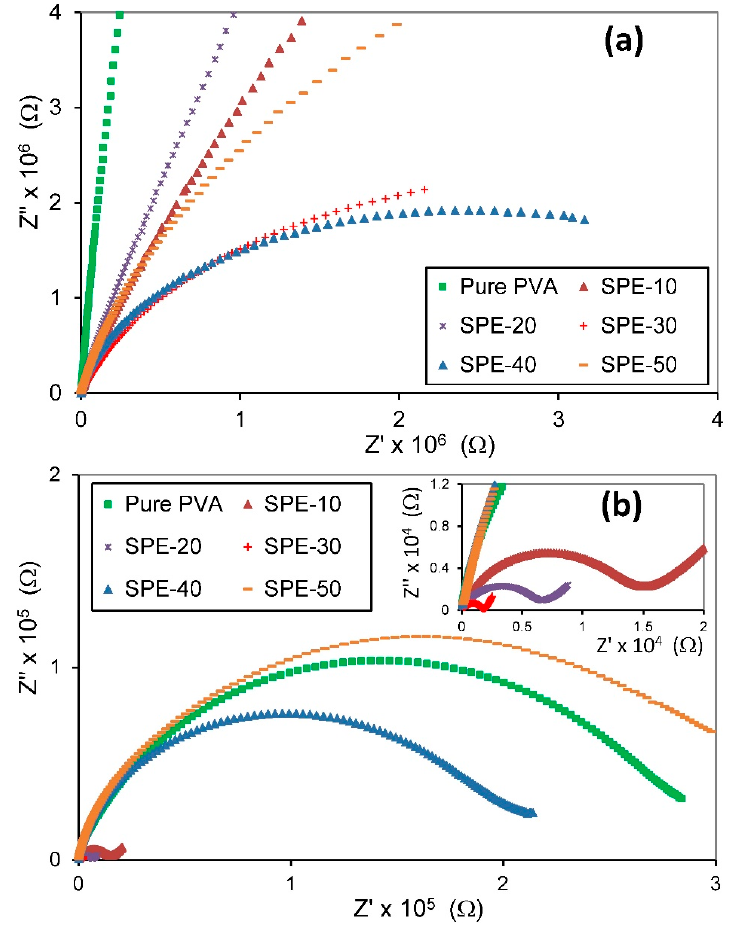
Figure 4. Cole-Cole plots for pure PVA and PVA/NH 4 NO 3 proton-conducting SPE films at temperatures ( a ) 303 and ( b ) 353